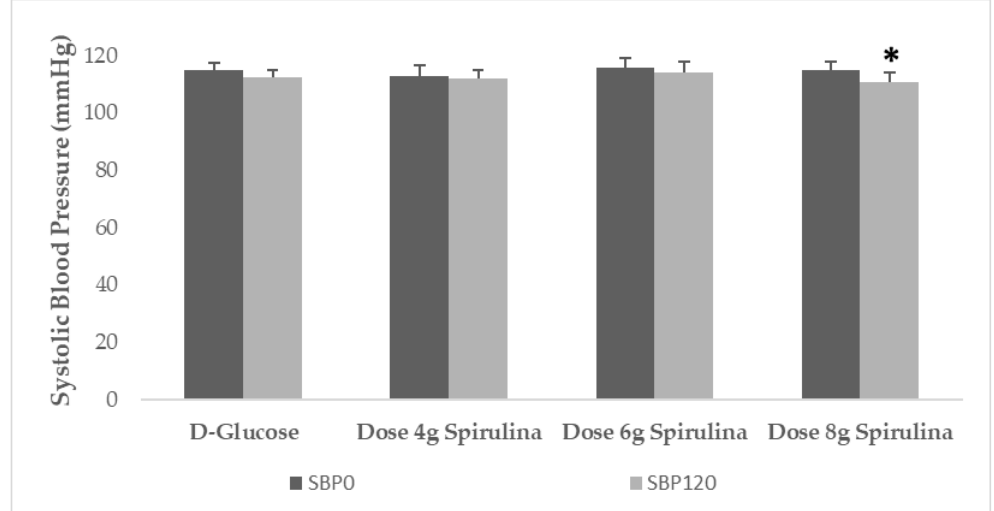
Figure 4. Systolic blood pressure (SBP) at baseline and 120 min post-test beverage consumption. Beverages tested were 50 g D-glucose with 4 g spirulina, 50 g D-glucose with 6 g spirulina, 50 g D-glucose with 8 g spirulina, and the reference test beverage 50 g D-glucose ( n = 13). Data are means ± SEM. Data were compared by repeated measures analysis using post hoc Tukey test with Bonferroni correction. * = p < 0.05. Abbreviations: SBP0: systolic BP at baseline. SBP120: systolic BP at 120 min post-test beverage.